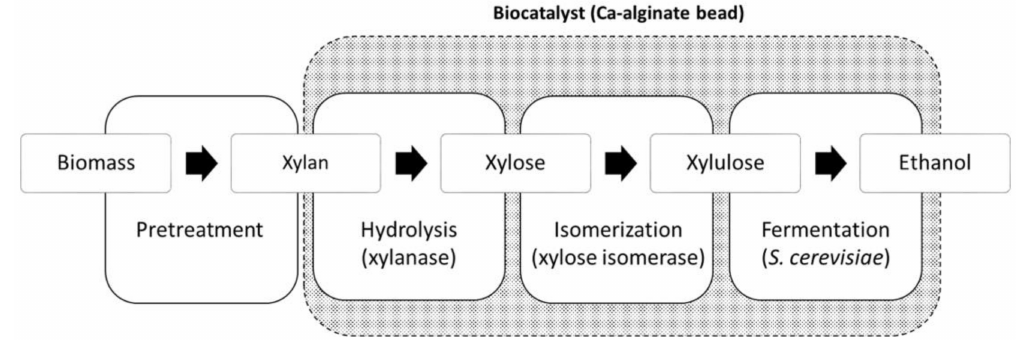
Figure 1. Xylan biomass simultaneous hydrolysis, isomerization, and fermentation (SHIF). Biocatalyst composed of xylanases, xylose isomerase, and co-immobilized S. cerevisiae